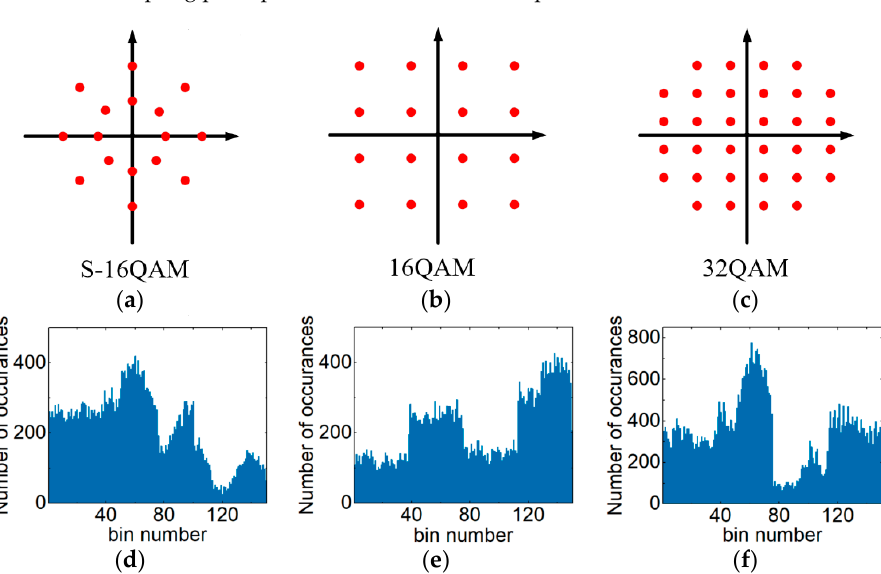
Figure 2. ( a – c ) Constellation diagram of different modulation formats: ( a ) S-16QAM, ( b ) 16QAM and ( c ) 32QAM. ( d – f ) ACHs with different modulation formats: ( d ) PDM-S-16QAM, ( e ) PDM-16QAM and ( f )